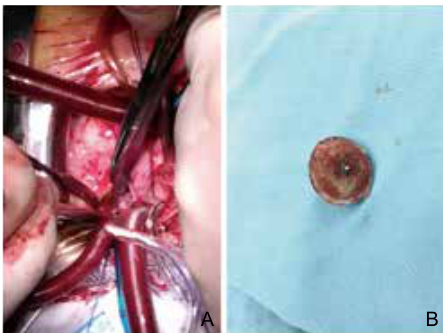
Figure 3 The device was found during surgical exploration and the * points to the ASO (A). The ASO was partly endothelialized (B).